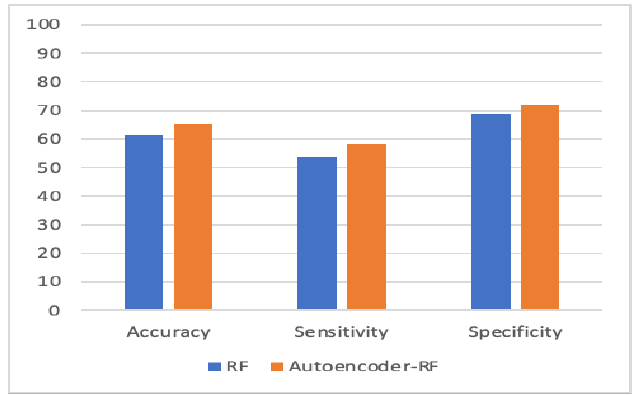
Figure 11. Autoencoder-SVM vs. SVM.